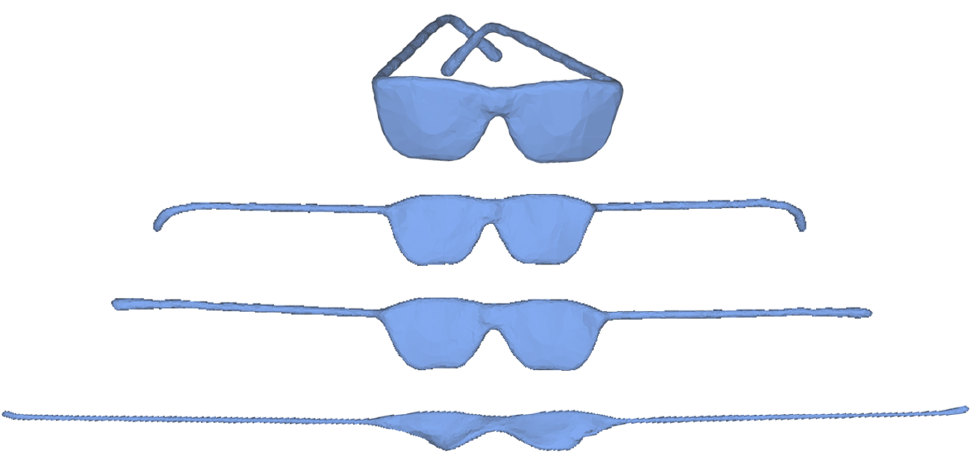
Figure 4. The influences of different initial β . Original glass model ( top ) understretches with β = 10 × 10 6 ( second row ), overstretches with β = 1 × 10 6 ( fourth row ), and unfolds well with β = 5 × 10 6 ( third row